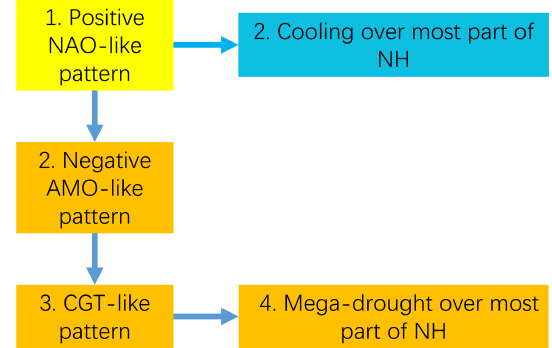
Figure 10. Schematic diagram showing the mechanisms behind the 4.2kaBP